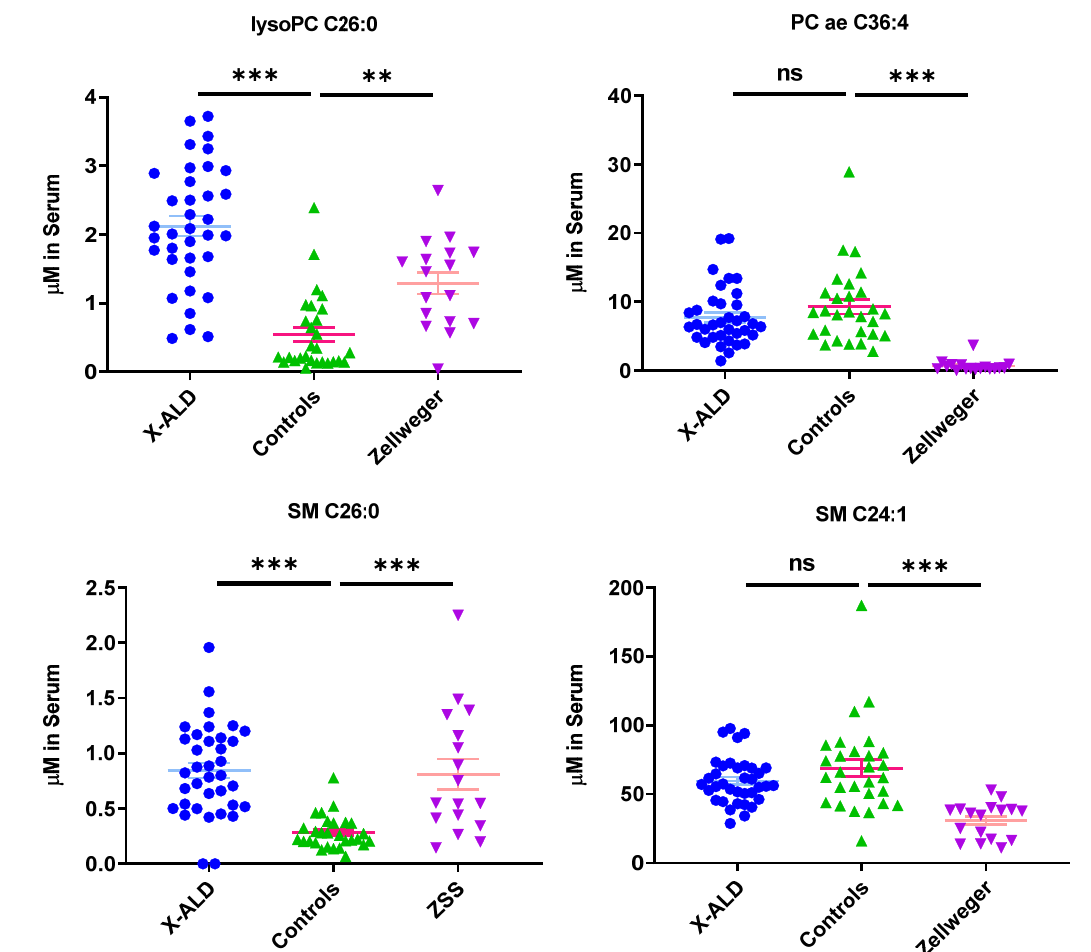
Figure 3. Phospholipids indicate differential phenotype between Zellweger syndrome spectrum patients (ZSS) and X-linked adrenoleukodystrophy (X-ALD) patients, as well as controls. Mean ± SEM, n = 36 (X-ALD/ ABCD1 ), 28 (Controls), 17 (ZSS/ PEX1 ). ns: not significant, ** p < 0.01, *** p < 0.001 after one-way ANOVA multiple comparisons analysis, Tukey